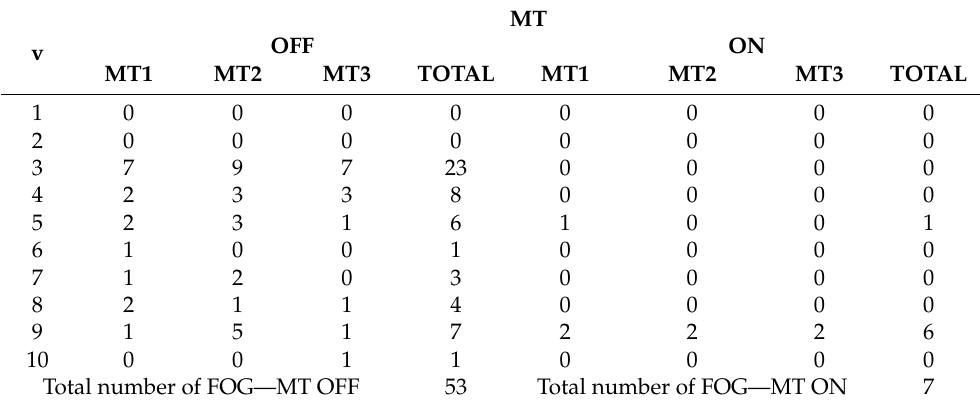
Table 4. Number of FOG episodes for each volunteer and the total number of FOG episodes during the OFF- and ON-medication states for the physical mobility motor task (MT).